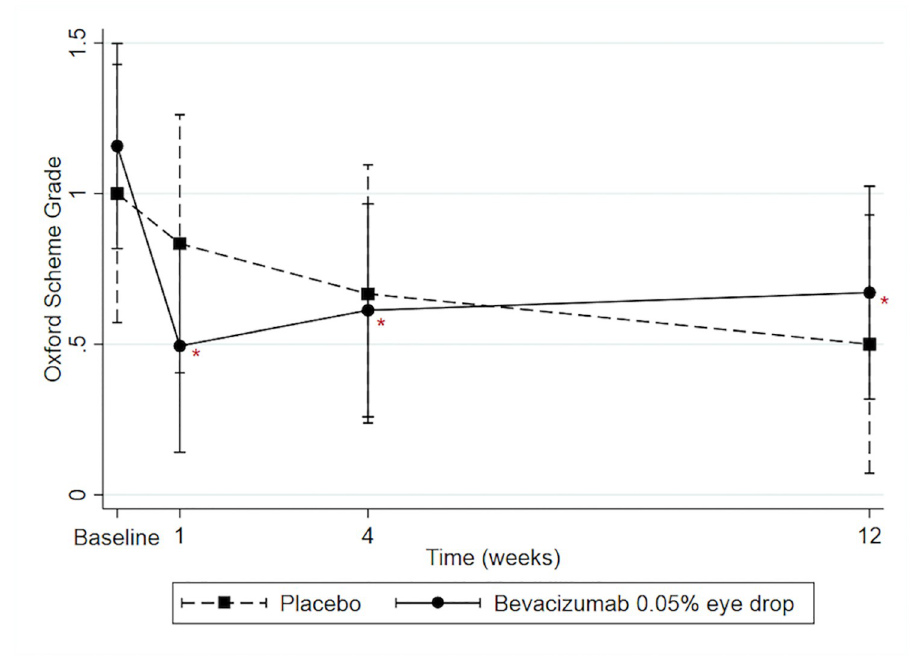
Fig 3. Predicted Oxford scheme grade (0–5) with 95% confidence intervals. � Represents significant difference compared with baseline within group (P < 0.05).